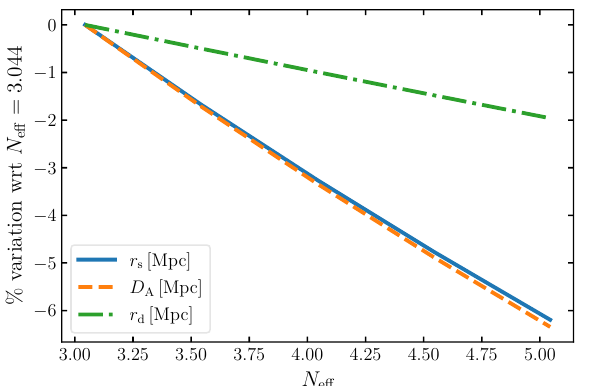
Figure 1. Percentage variation of the distances r s (blue solid line), D A (orange dashed line), and r d (green dot-dashed line) at recombination with respect to their reference values for N eff = 3.044. The distances are computed fixing θ s , therefore r s and D A show similar variations.